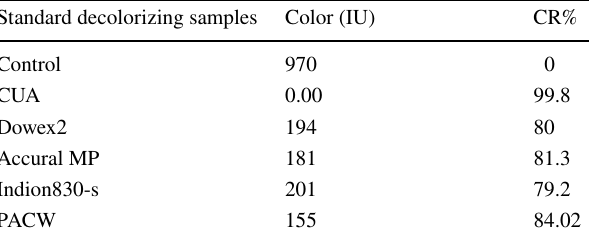
Table 3 Decolorization of soluble raw sugar solution by different standard adsorbent materials Standard decolorizing